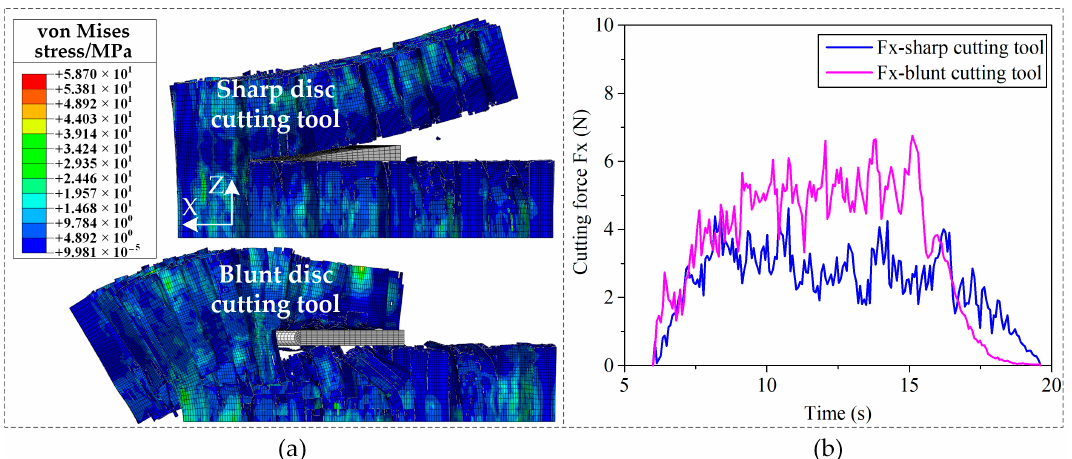
Figure 8. Predicted stress distributions and cutting forces with different cutting tool tip geometries: ( a ) predicted stress distributions; ( b ) predicted cutting forces.